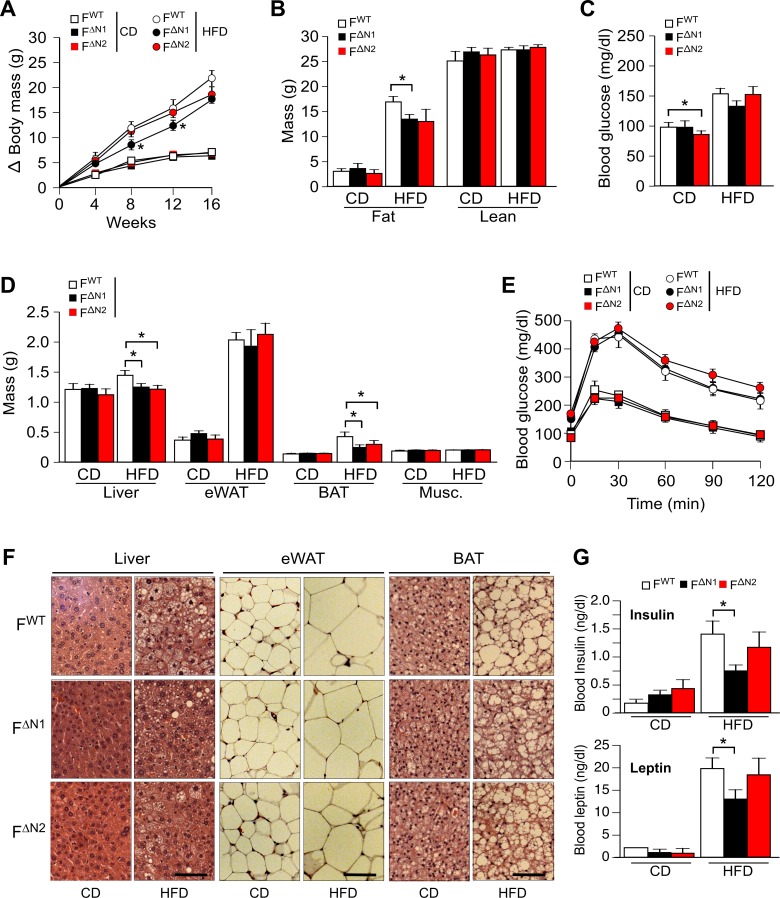
Effect of adipose tissue-specific ablation of the Nova1 or Nova2 genes.(A) The change in body mass of FWT, F∆N1 and F∆N2 mice fed a CD or ais presented (mean ± SEM; n=8~21). (B) Body composition was examined by proton magnetic resonance spectroscopy (mean ± SEM; n=8~21). (C) Blood glucose concentration in overnight starved CD-fed and HFD-fed (16 wks) mice (mean ± SEM; n=8~21). (D) The mass of the liver, epididymal white adipose tissue (eWAT), interscapular brown adipose tissue (BAT), and gastrocnemius muscle (Musc.) of FWT and F∆N1,2 mice fed a CD or a(16 wk) is presented (mean ± SEM; n=8~21). (E) CD-fed and HFD-fed (16 wks) mice were examined by glucose tolerance tests (mean ± SEM; n=8~21). (F) Sections of the liver, eWAT, and BAT were stained with hematoxylin and eosin (n=6). Scale bar, 100 µm. (G) Blood insulin and leptin in overnight starved mice were measured (mean ± SEM; n=8~21). Statistically significant differences between Control and NOVA-deficient mice are indicated: *p<0.05.